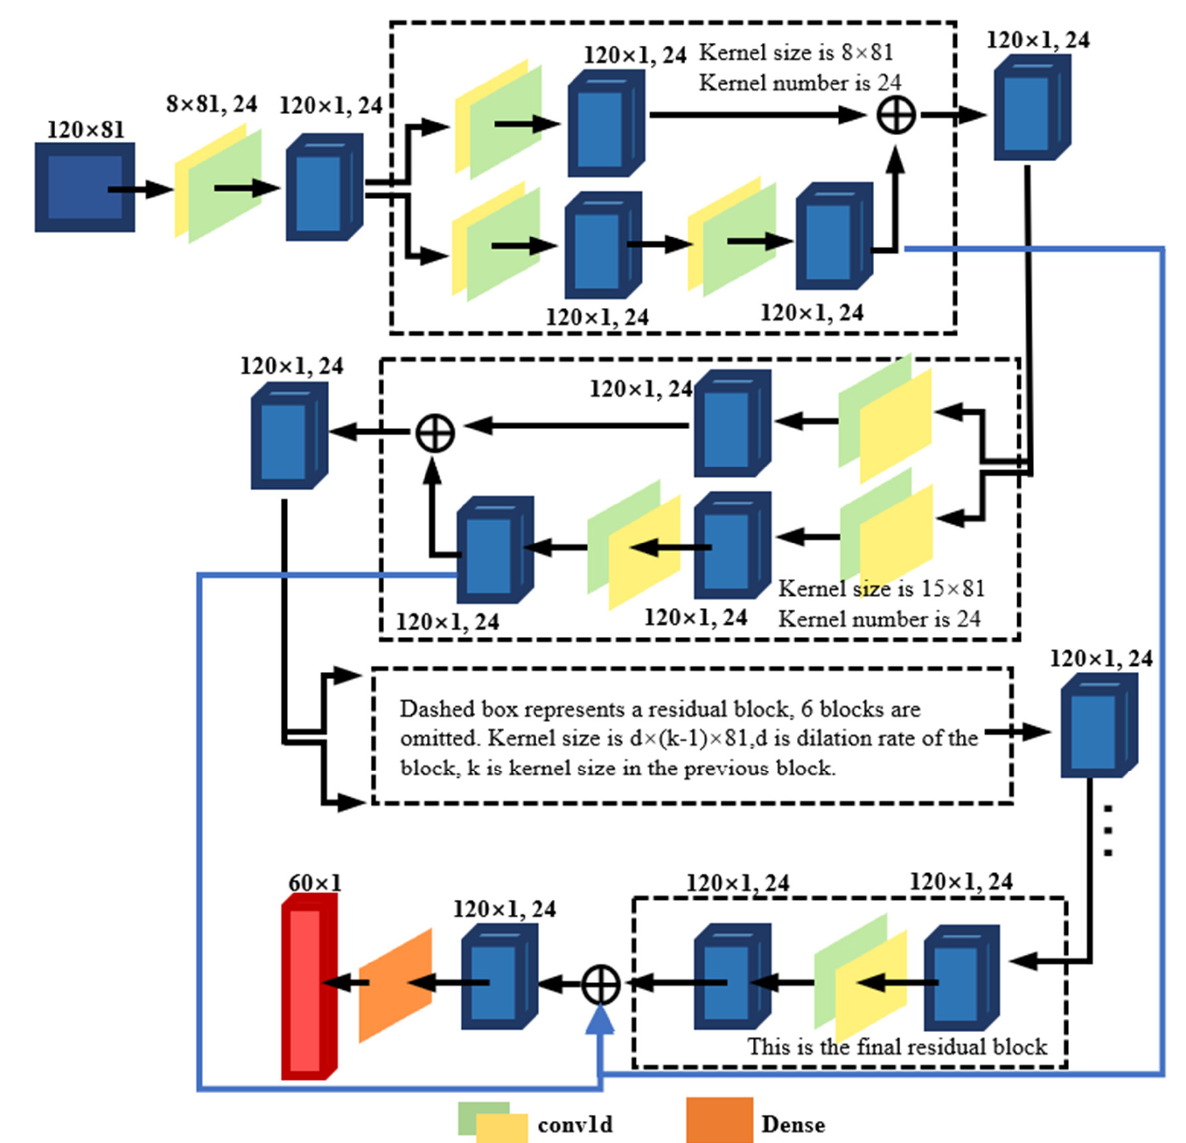
Figure 1. TCN structure, including nine residual blocks and one fully connected layer.